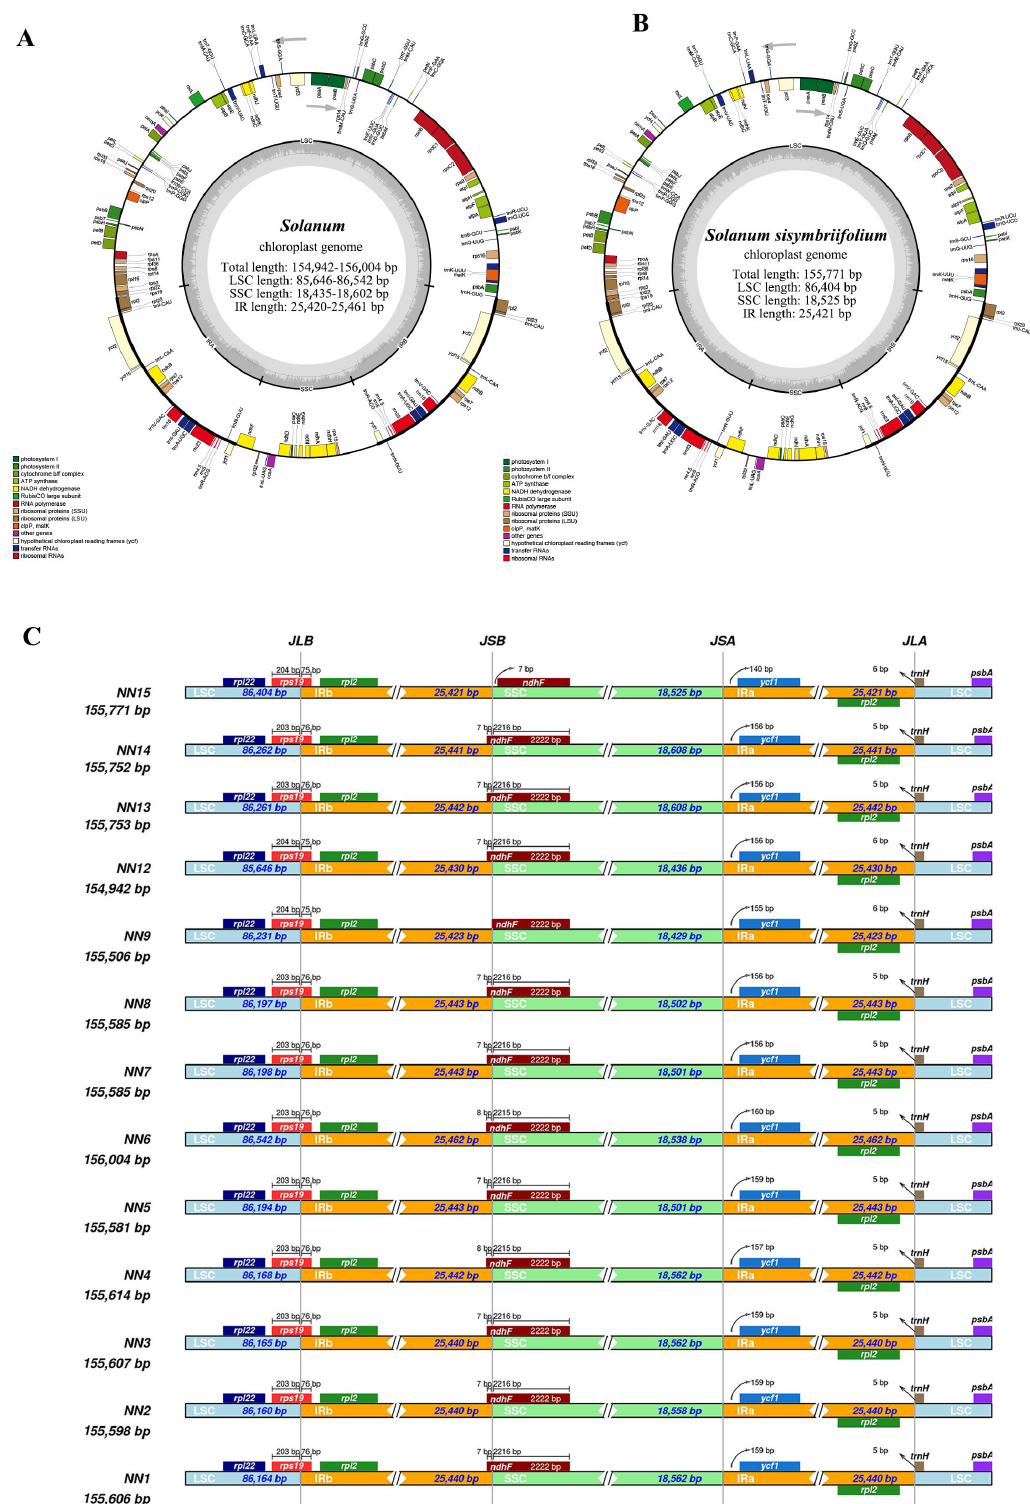
Figure 1. Structure of 13 cp genomes. ( A ) The circle characteristic of the reference genome cp genomes ( S. melongena ). ( B ) The physical map of the circular cp genome of S. sisymbriifolium . Genes shown inside the outer circle are transcribed counterclockwise, and those outside are transcribed clockwise. Genes belonging to different functional groups are color-coded. A gray area in the inner circle indicates the GC content. ( C ) Comparison of the borders of large single-copy (LSC), small single-copy (SSC), and inverted repeat (IR) regions among the cp genomes of 13 cp